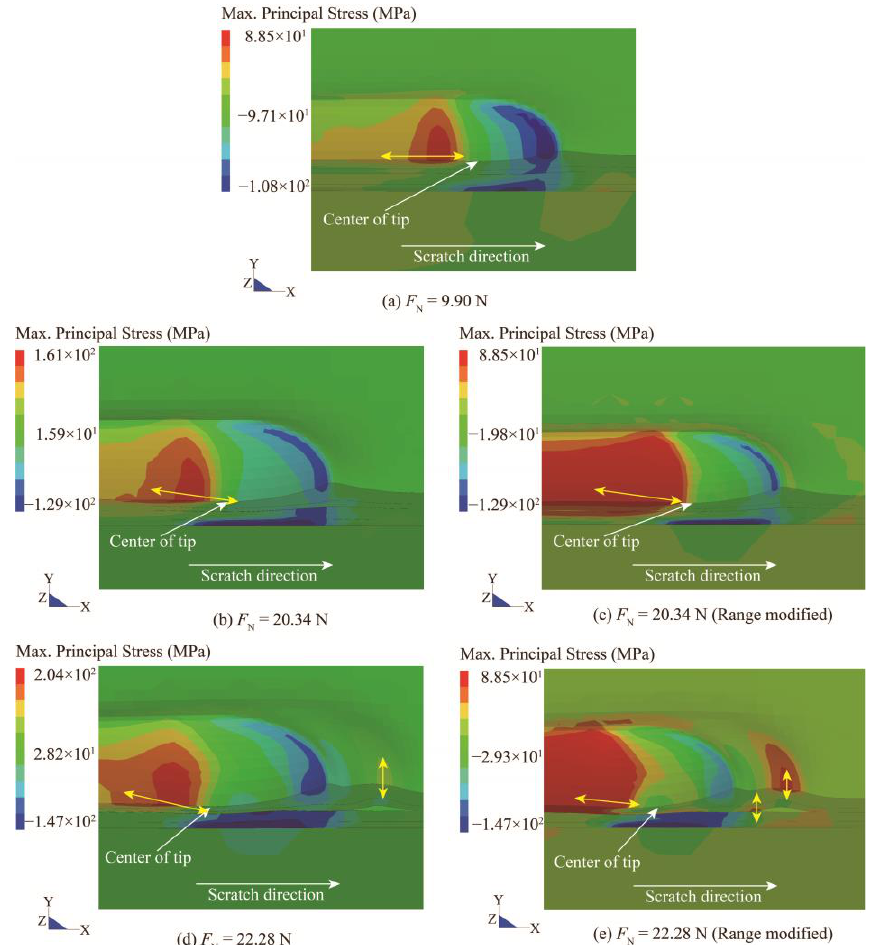
Figure 10. The maximum principal stress contour beneath the scratch tip during scratching at the normal load of ( a ) the onset of cracking; ( b , c ) delamination initiation; ( d , e ) plowing.